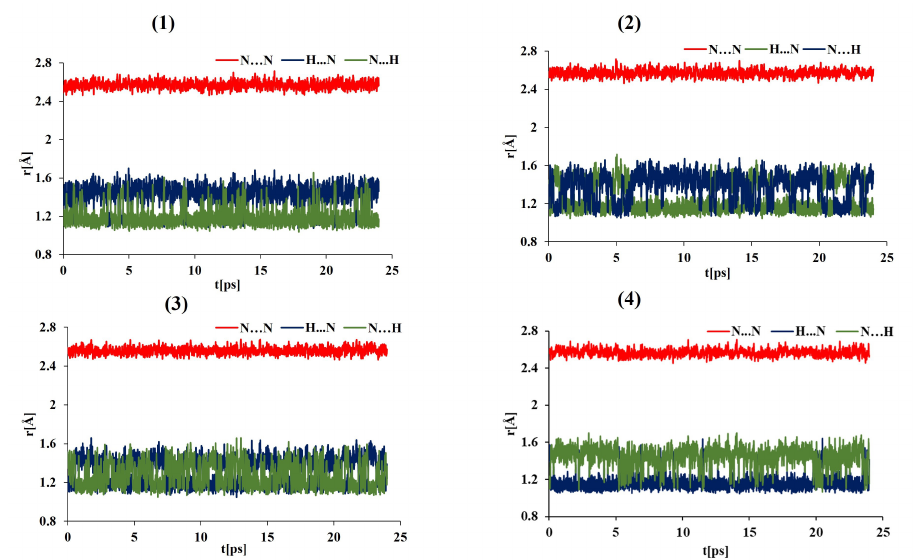
Figure 6. Time evolution of the intramolecular hydrogen bond metric parameters. Crystalline phase CPMD results at 100 K for DMANH + and its derivatives.